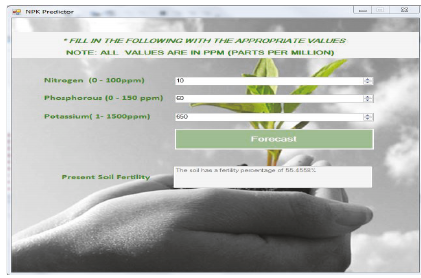
Figure 4: Reading dialog interface showing a user’s input.